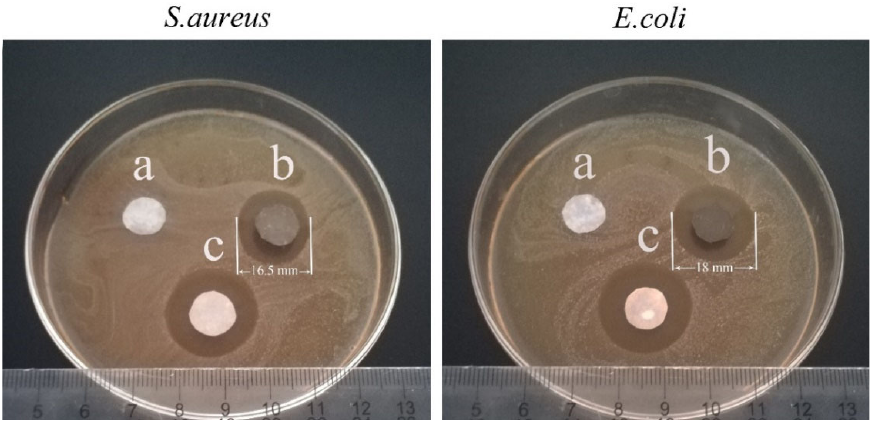
Figure 8. Digital photographs of the inhibition zone formed in antibacterial test of the ( a ) ANF film, ( b ) ANF@Ag nanocomposite film and ( c ) antibiotic blank sample (treated by tetracycline) against E. coli and S. aureus